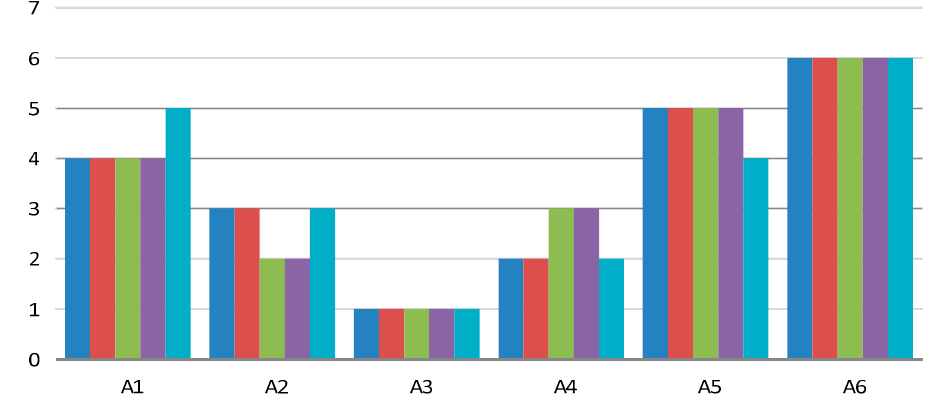
Figure 4. Values of Spearman’s coefficient through 68 scenarios.